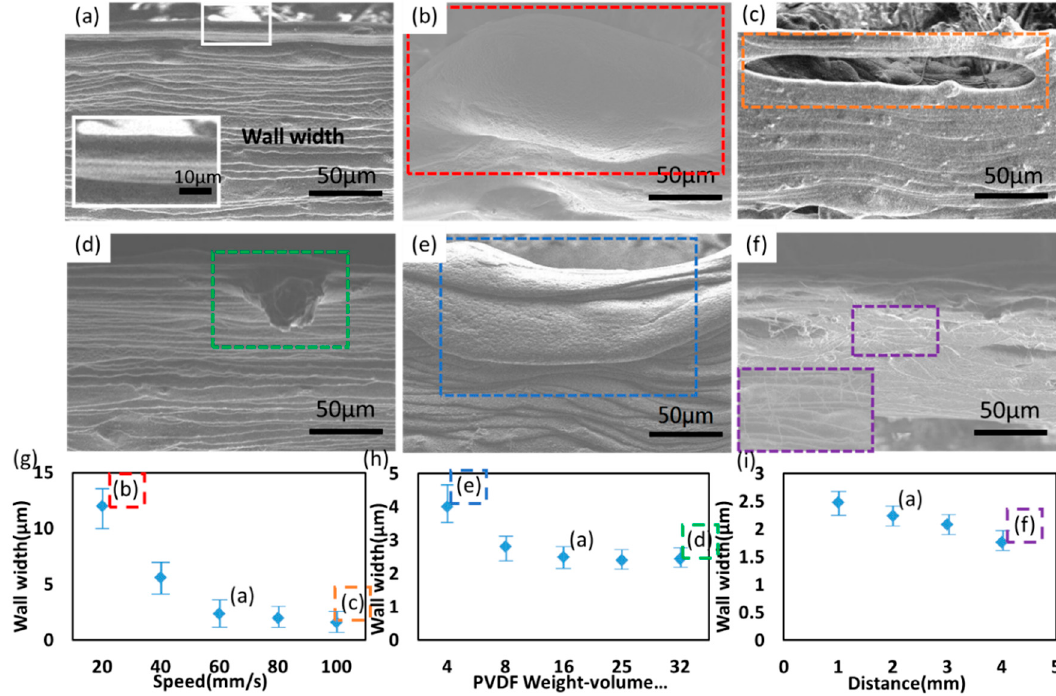
Figure 2. ( a ) The morphology of 3D electrospun PVDF fibers with the spinneret size of 27 G, applied voltage at 1.6 kV, 16 wt % PVDF solution, 60 mm/s x-y stage speed and 2 mm spinneret-to-collector distance under SEM. The above processing conditions are selected as the basis. The inset shows a magnified view. SEM images showing the morphology of 3D electrospun PVDF fibers with respect to ( b ) 20 mm/s x-y stage speed ( c ) 100 mm/s x-y stage speed ( d ) 32 wt % PVDF solution ( e ) 8 wt % PVDF solution ( f ) 4 mm spinneret-to-collector distance. Plots showing the dependence of wall width with respect to ( g ) PVDF weight-volume percentage, ( h ) motion speed of the x-y stage, ( f ) spinneret-to-collector distance. The experimental data are the collection of ten samples, with the average values and error bars showing the distribution. The insets of red/orange/green/blue/purple dotted rectangle in ( g – i ) correspond to the NFES processing parameters in ( b – f ).